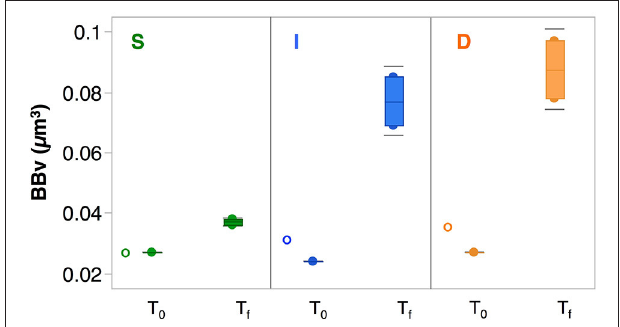
FIGURE 3 | Prokaryotic cell size distribution. Distribution of prokaryotic cell size, represented as bacterial bio-volume (BBv, µ m 3 ), at the initial time (T 0 ) and final time (T f ) of the incubations from water taken at surface (S, green), intermediate (I, blue) and deep scattering (D, orange) layers. The empty circles represent the BBv measured from the niskin sample, before the filtration for the experiment was performed. The horizontal line inside the boxes represents the mean value, and the horizontal gray lines outside the boxes indicate the standard deviation.